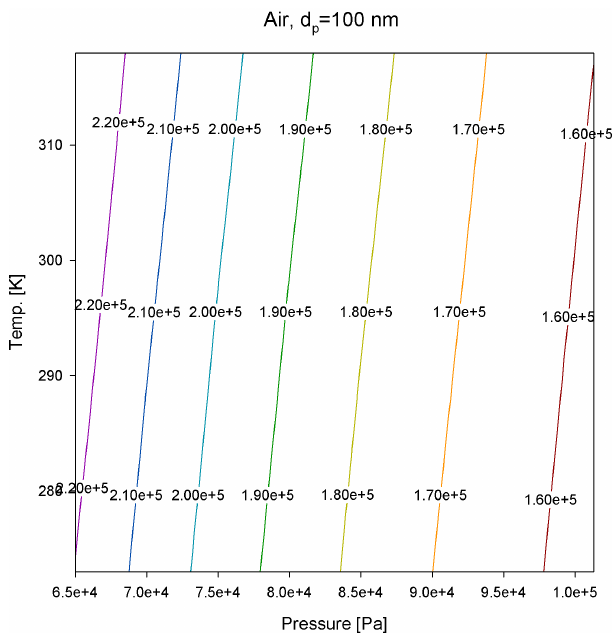
Figure 2. C c ratio for various temperatures and pressures. µ